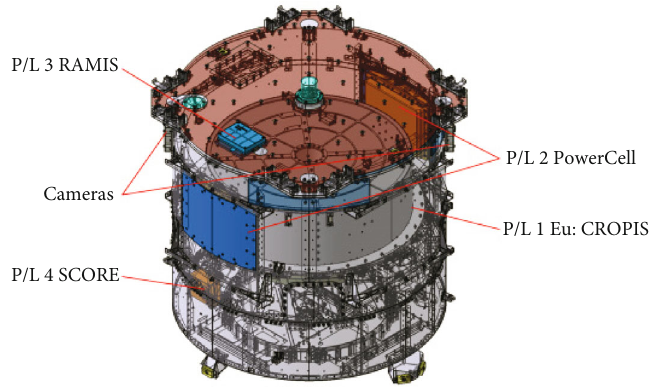
Figure 2: Eu:CROPIS payload distribution.